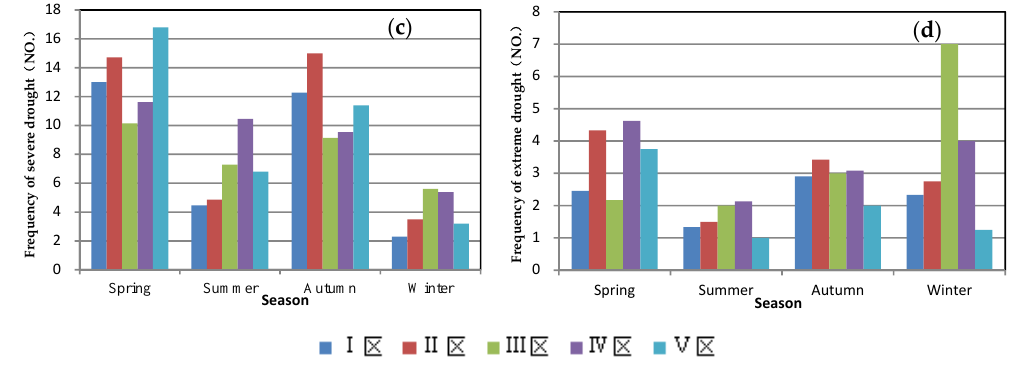
Figure 7. Intraannual frequency of light droughts ( a ), moderate droughts ( b ), severe droughts ( c ), and extreme droughts ( d ) for the five sub ‐ regions of the Haihe River Basin.